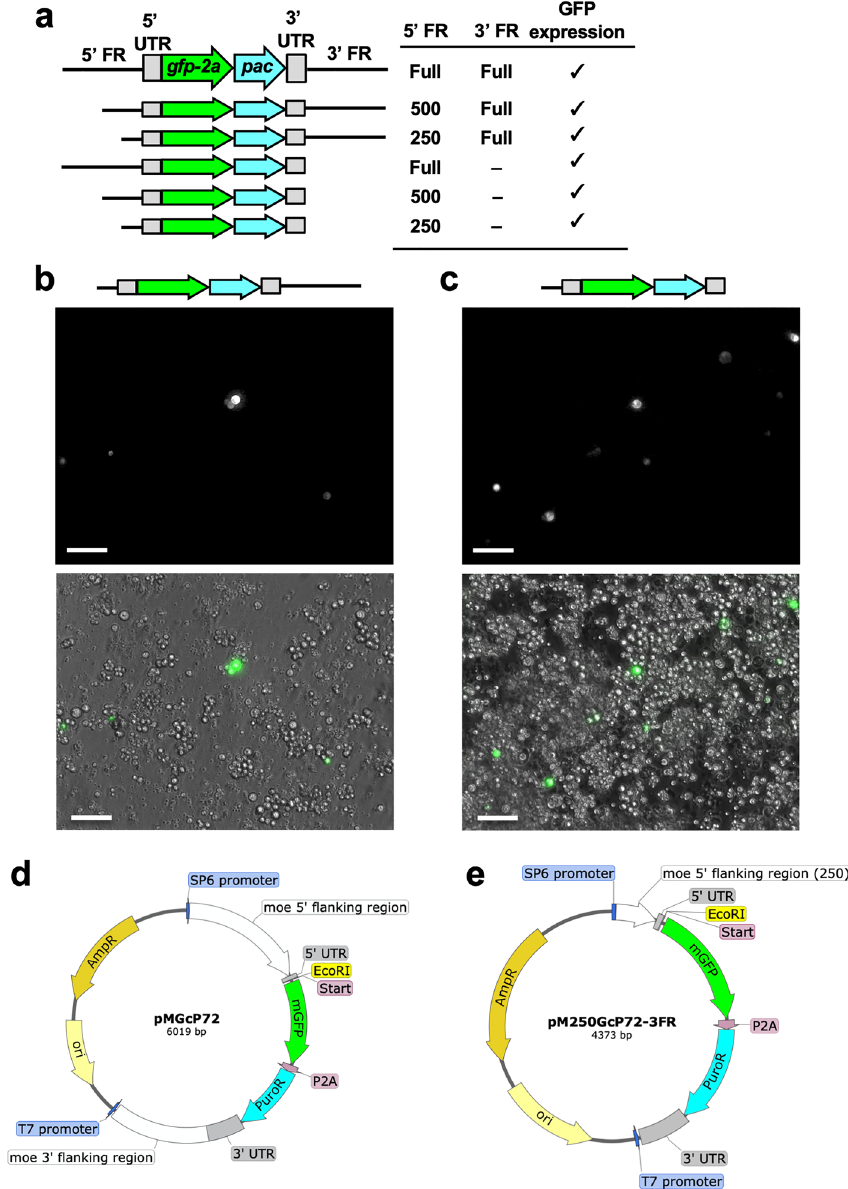
Figure 4. Requirement of 5’ and 3’ flanking regions of moe gene for GFP expression in the CRTW-3HE strain. ( a ) Schematic diagrams between 5 ′ and 3 ′ flanking regions (FR) of the tested plasmids (left side). The length of FRs and results of GFP expression are shown on the right side. ( b and c ) Representative images of GFP expression by promotor activity of 250 bp 5’ FR with and without 3’ FR are shown in ( d ) and ( e ), respectively. The scale bars; 50 µm. Schematic diagrams of pMG C P72 ( d ) and pM250GcP72-3FR ( e ) are shown. The images are provided by SnapGene